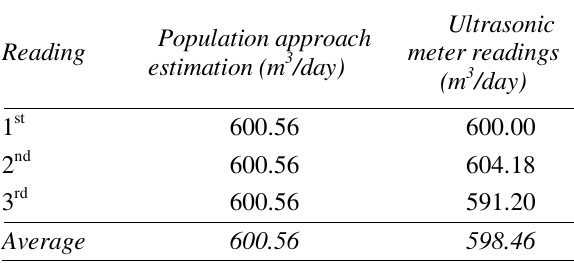
Table 1(a): Estimated waste discharges to waste stabilization ponds